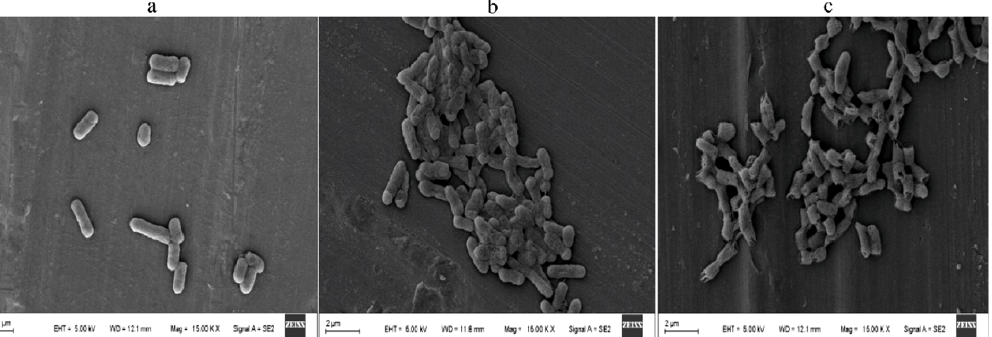
Figure 10. The electron scanning micrograph of E. coli. ( a ) The blank group after treatment for 4 h; ( b ) The MIC group after treatment for 4 h; ( c ) The MBC group after treatment for 4 h.